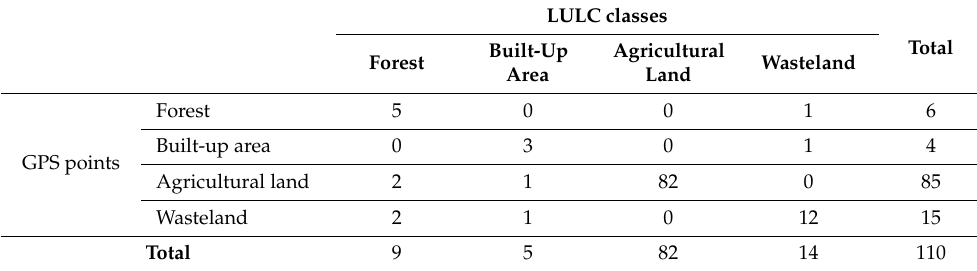
Figure 5. ( a ) Land use/land cover. ( b ) Geomorphology. ( c ) Road buffer. ( d ) NDRLI. Table 9. Theoretical error matrix of LULC classification.